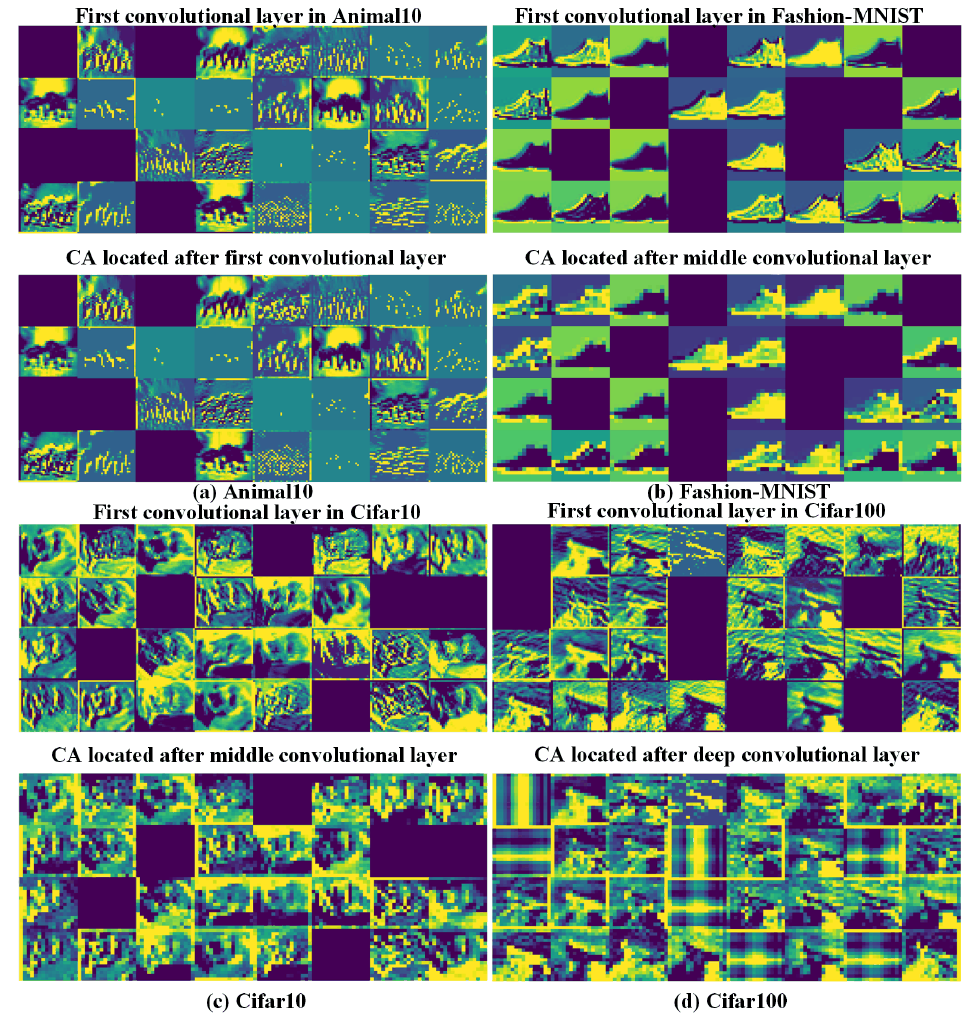
Figure 7. Output of feature maps by CA layers in different positions.